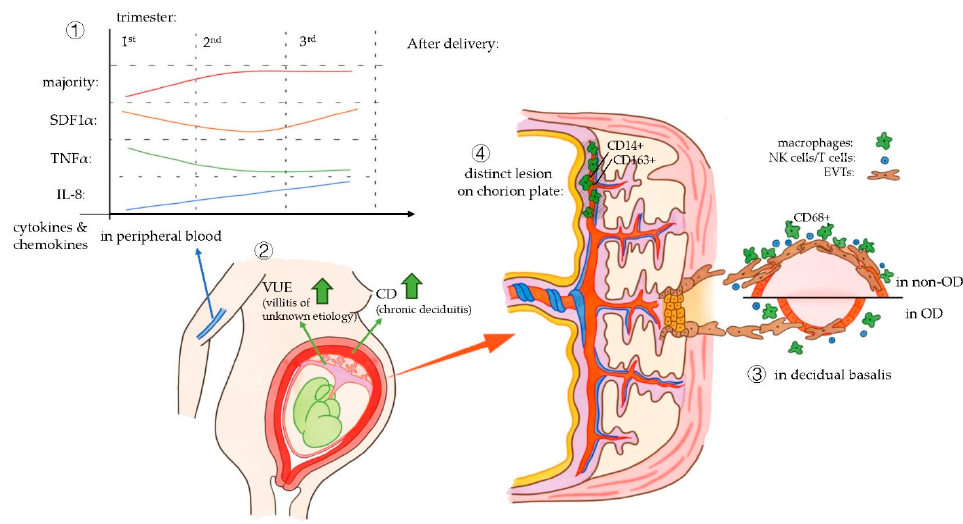
Figure 2. Main outcomes of four articles which are included in this systematic review.: ① The results of the study by Martinez-Varea et al., in peripheral blood. ② The results of the study by Gundogan et al. on placenta pathology findings in OD pregnancies. ③ The study by Nakabayashi et al. with the results on impaired vascular remodeling in the decidual basalis of OD pregnancies. ④ The study